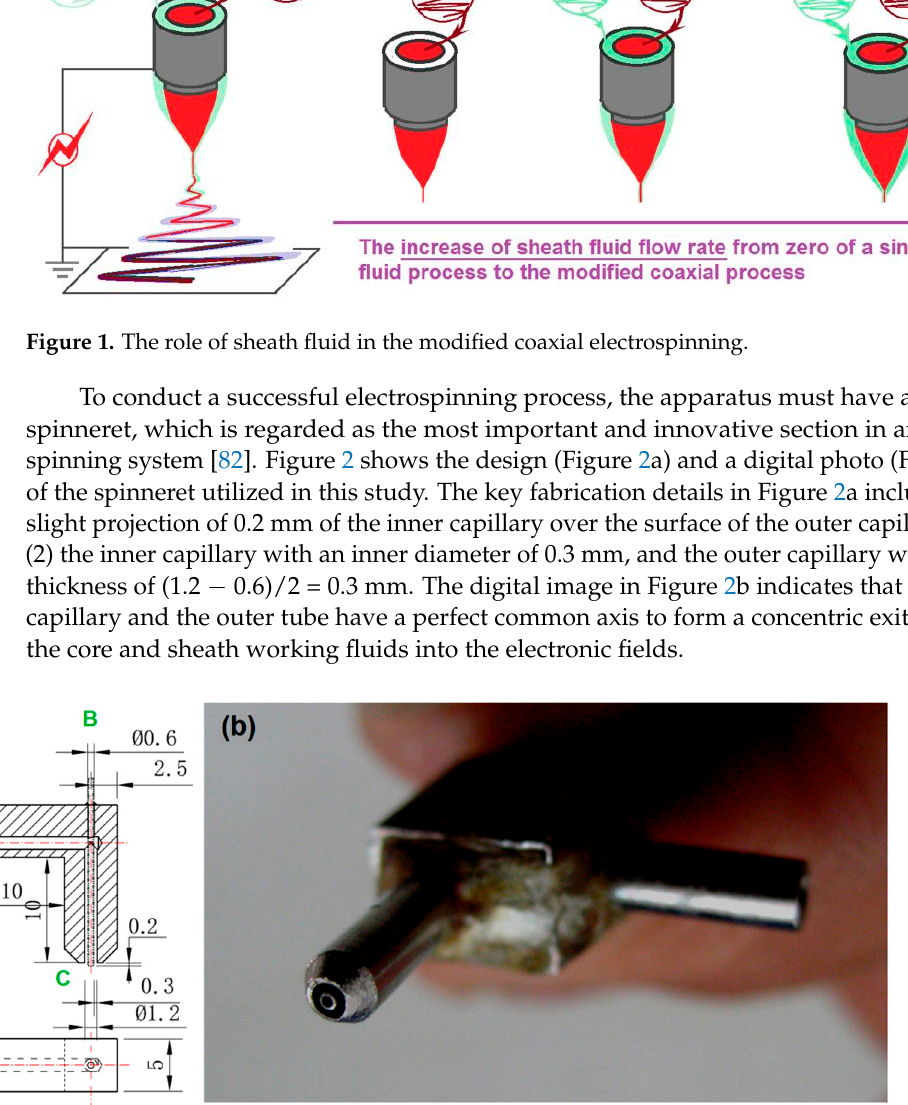
Figure 2. The applied concentric spinneret: ( a ) design of the fabrication details, A and B are the inlets of sheath and core fluids, respectively, and C is their co-exit ; ( b ) a digital photo of the concentric spinneret.